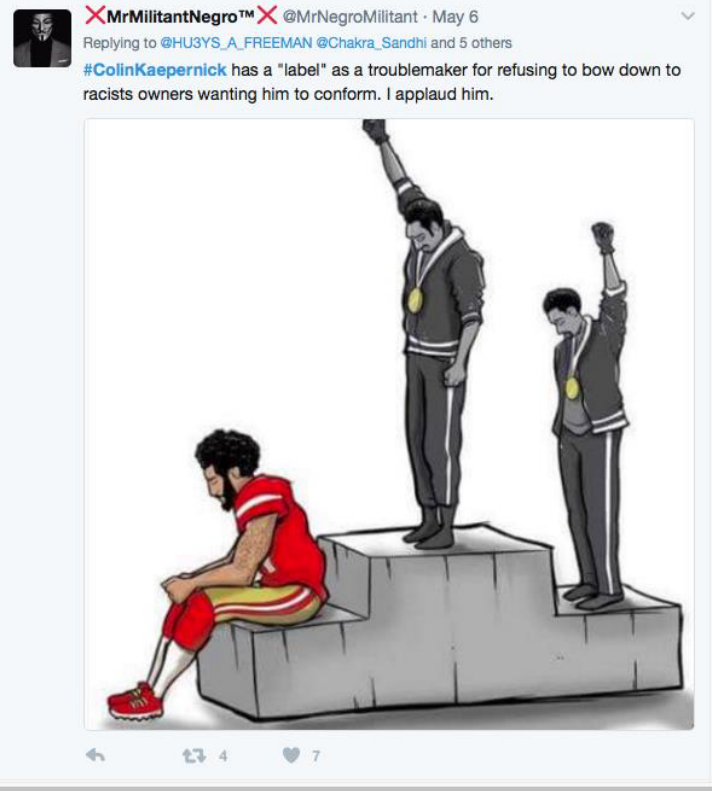
FIGURE 4 : THIS IMAGED IS A SCREENSHOT FROM THE TWITTER ACCOUNT OF MRNEGROMILLIANT. HIS MAY 2, 2017 TWEET OF THE IMAGE IS OF A RE-CREATION OF THE ICONIC IMAGE OF THE 1968 SUMMER OLYMPICS IN WHICH AMERICAN SPRINTERS JOHN CAROLS AND TOMMIE SMITH RAISED THEIR FIST (BLACK POWER SALUTE) DURING THE PLAYING OF THE NATIONAL ANTHEM DURING THE PODIUM